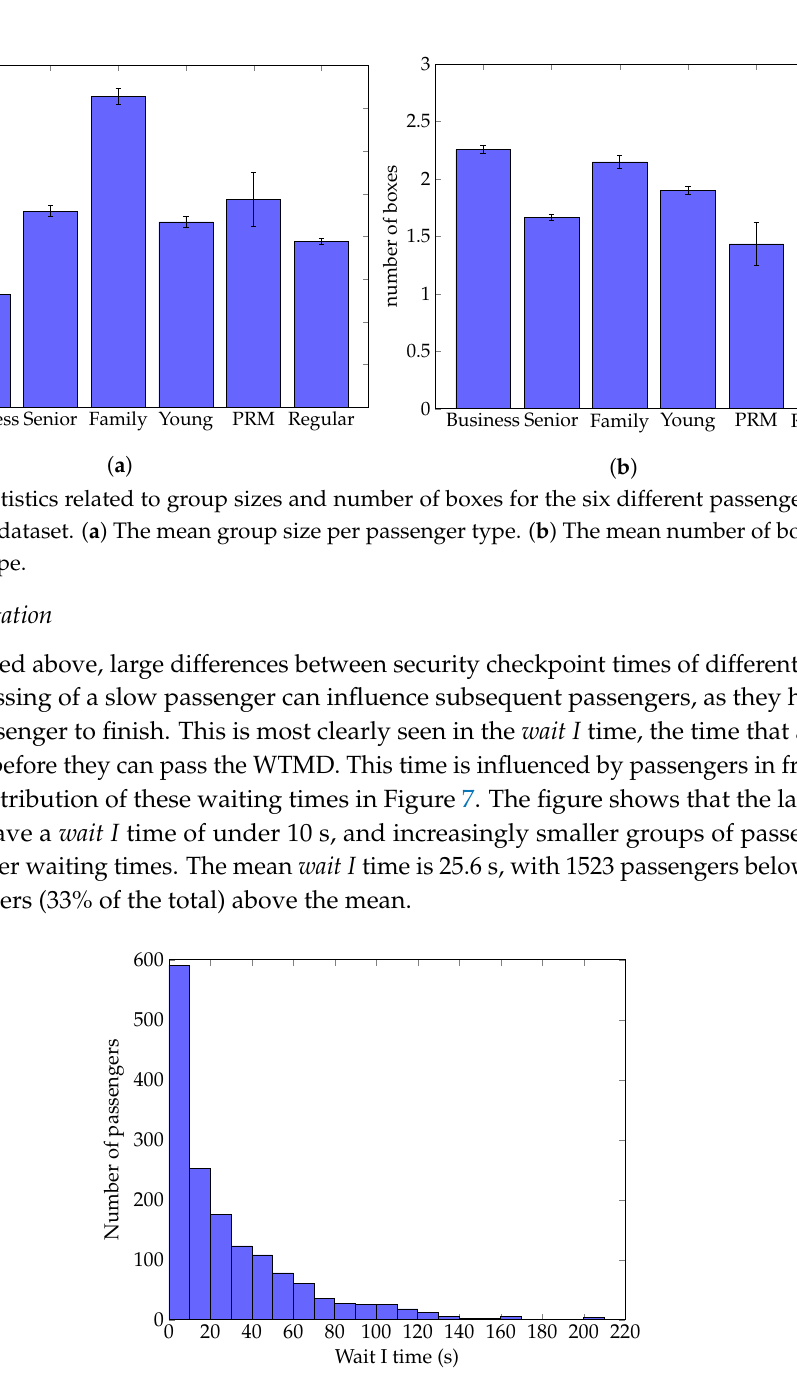
Figure 7. A histogram of wait I times for all passengers in the